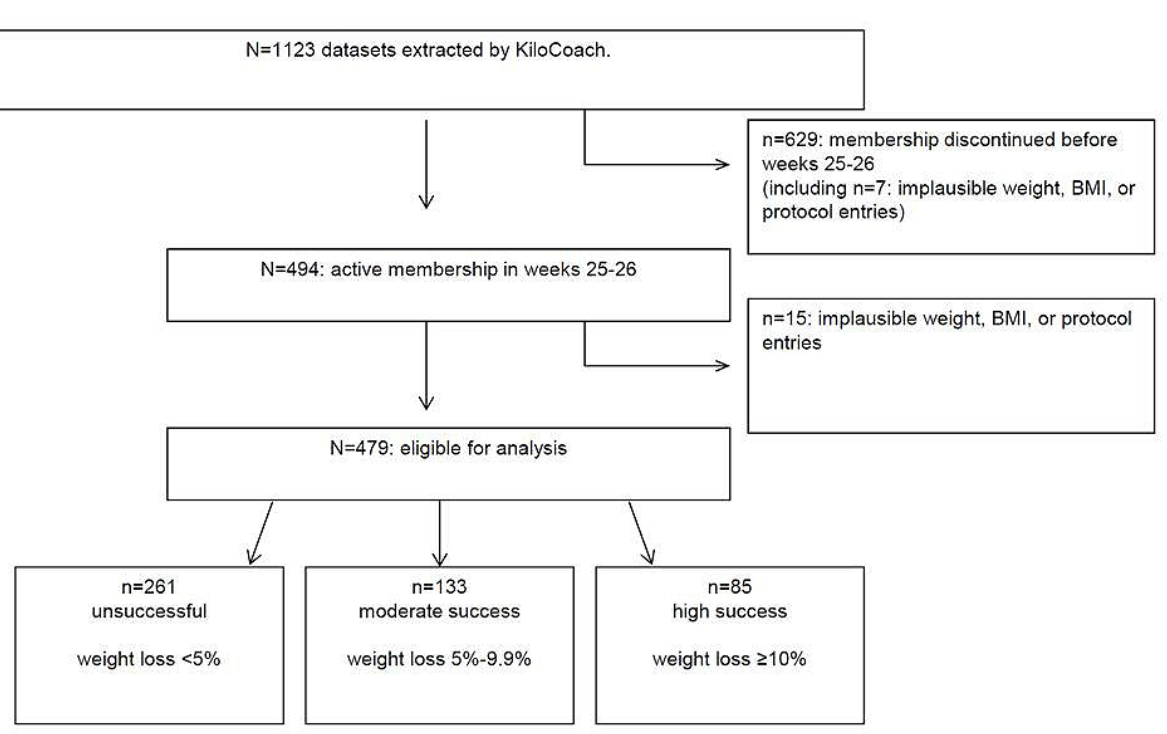
Figure 2. Dataset flow through the screening process to success group